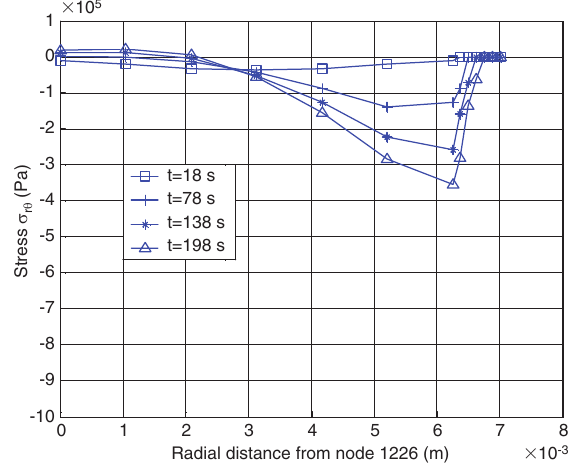
Figure 16 Shear stresses along radial direction at angle 103.5 ° from node 1226 to node 94 when moving heater is over the